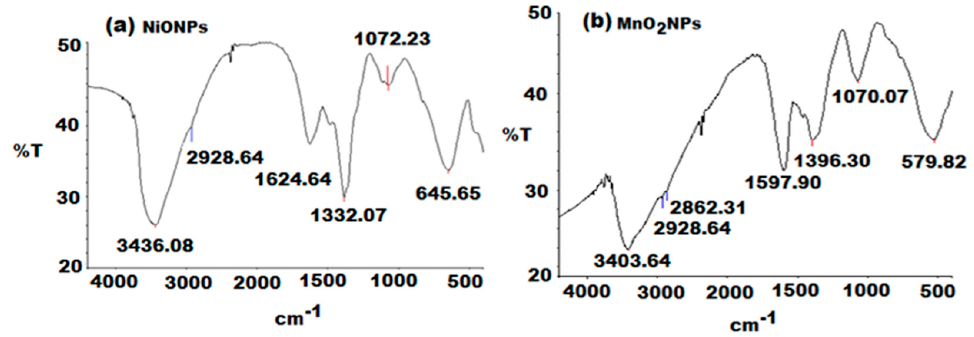
Figure 2. FTIR spectra in the range of 4000–500 cm − 1 of green synthesized ( a ) NiONPs and ( b ) MnO 2 NPs using Mentha spicata and Malus domestica peel extract, respectively.